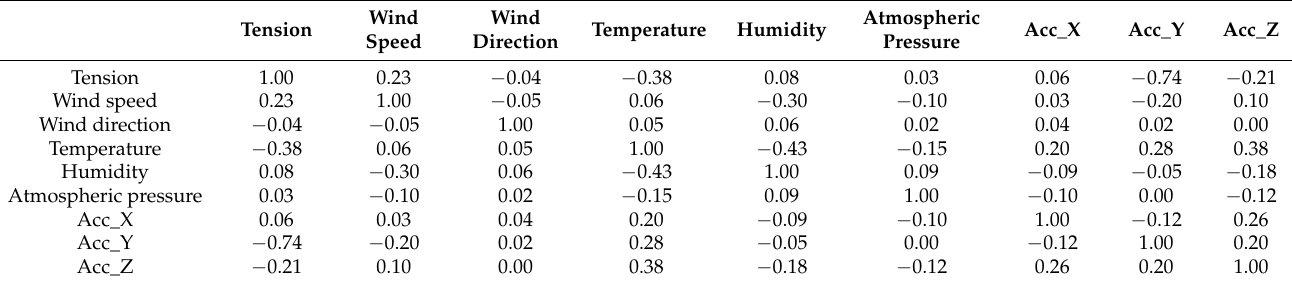
Table 2. The results of Pearson’s correlation analysis.